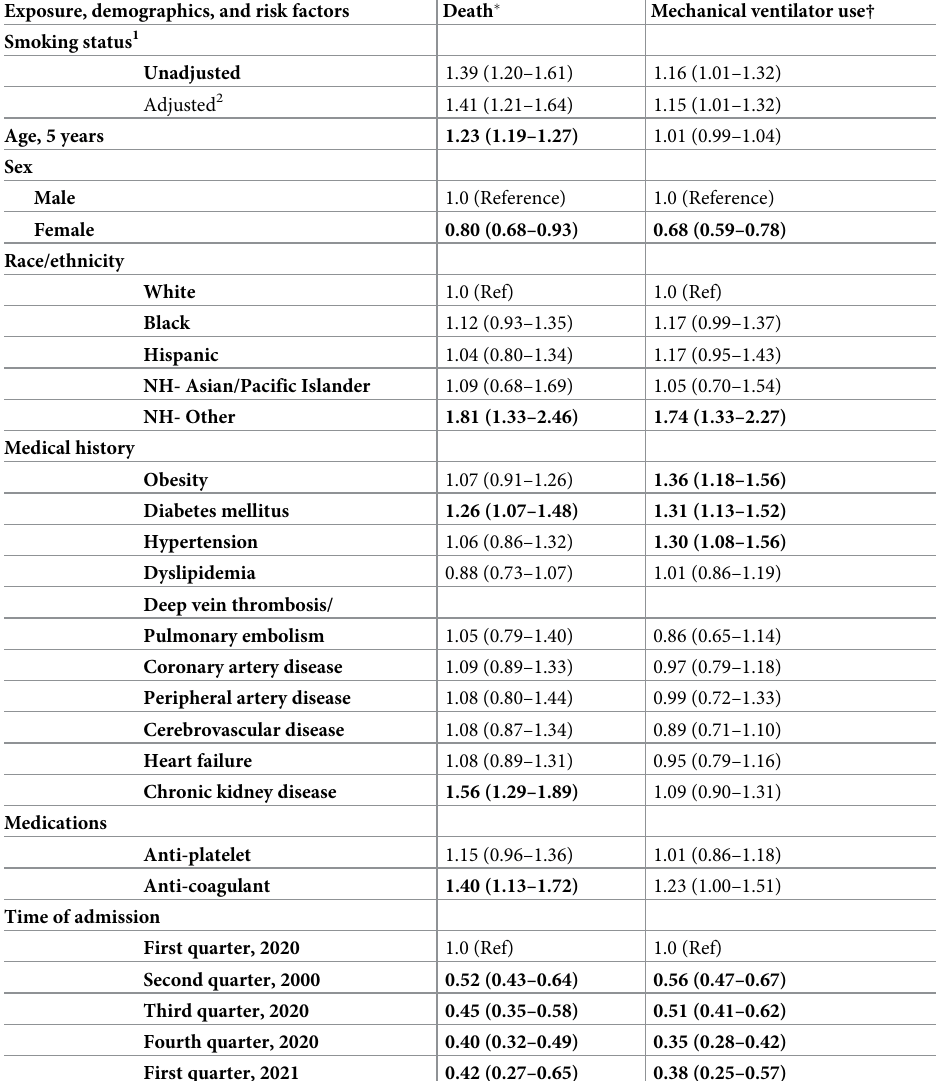
Table 3. Multivariate analysis of associations between characteristics and outcomes among the propensity- matched study population of the AHA COVID-19 CVD Registry from December 2020 to March 2021. Exposure, demographics, and risk